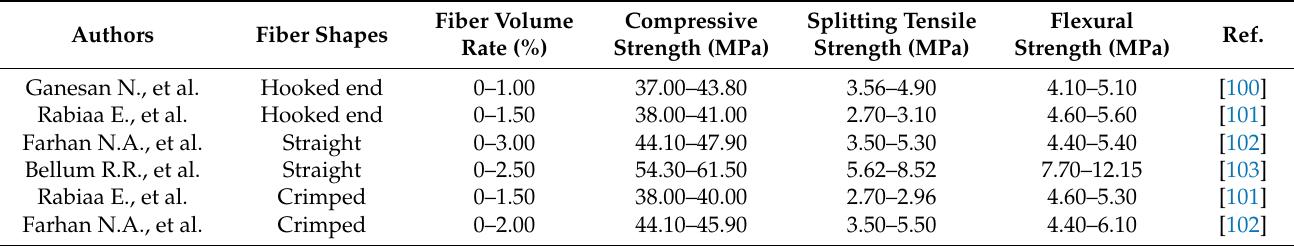
Table 7. The effect of steel fiber shape on geopolymer